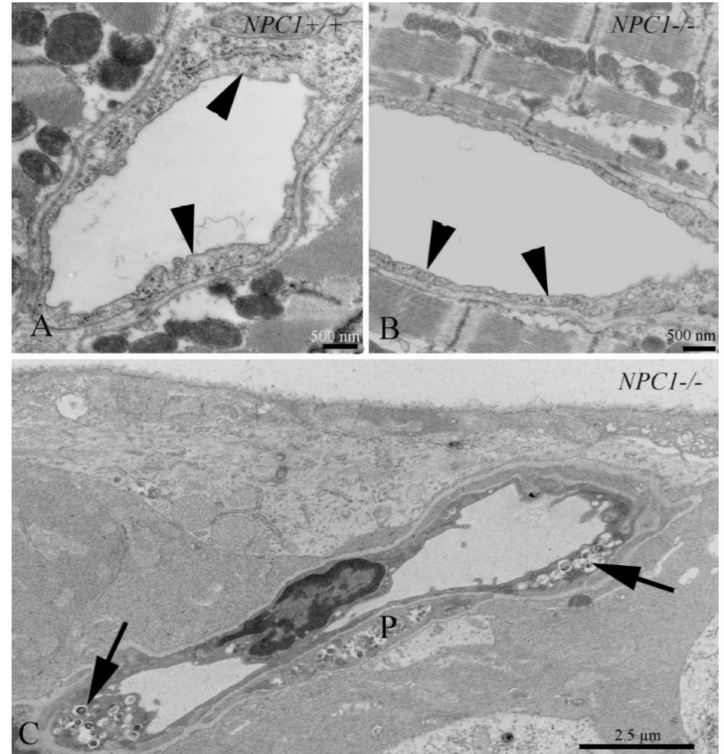
Figure 5. Phenotypes of NPC1 in the cardiovascular system. ( A ) Cardiac muscle with an endothelial cell (arrowheads) in an Npc1 +/+ (control) mouse. ( B ) Endothelial cells, in contrast to most other organs, do not contain lipid-like inclusions. ( C ) Capillary (arrows) and a pericyte (P) in the ganglion cell layer of the retina, are filled with NPC1-typical